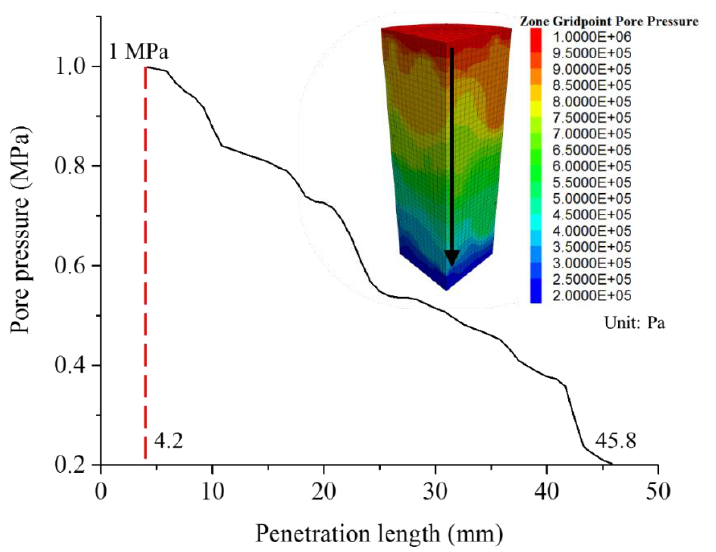
Figure 16. Pore pressure along vertical axis for model C1 (at axial strain of 0.0132, stationary phase)